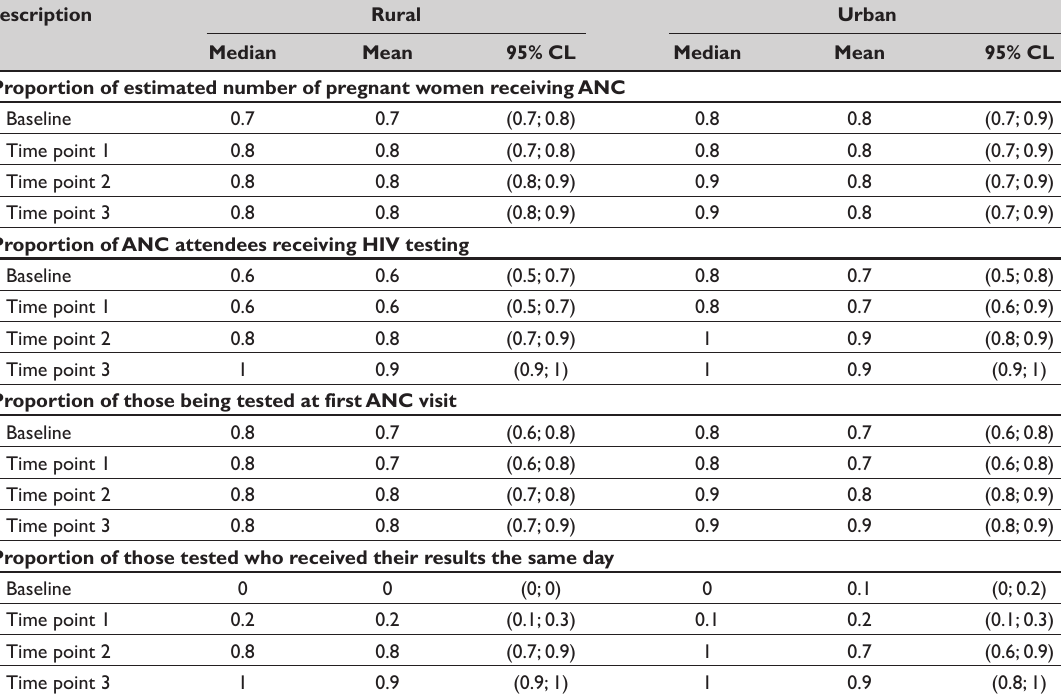
Table 1: Progress along the cascade of PMCT services by rural and urban ANC facility groups in Myanmar (2012-2015)